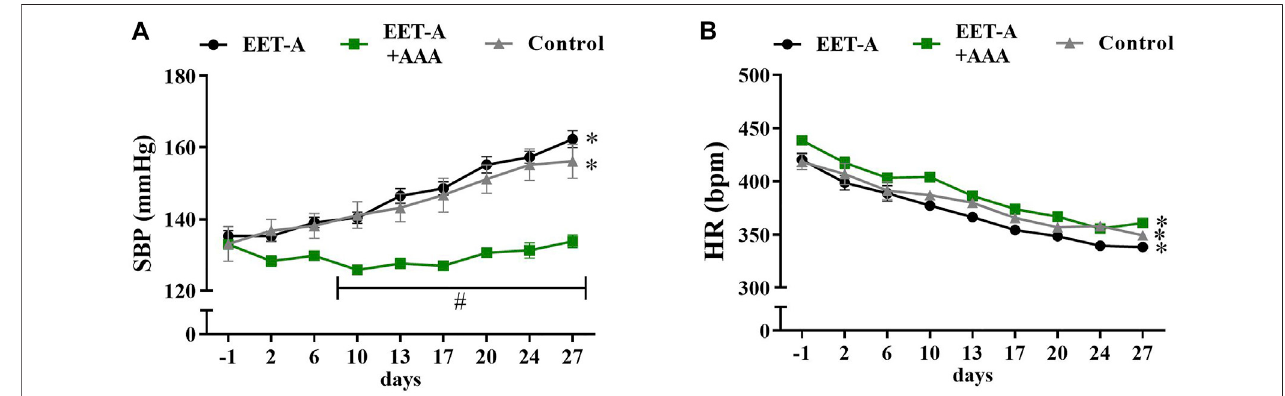
FIGURE 3 | Time course of (A) systolic blood pressure and (B) heart rates in young spontaneously hypertensive rats receiving epoxyeicosatrienoic acid analog alone (EET-A, n (cid:1) 7) or combined with 20-HETE receptor antagonist (EET-A + AAA, n (cid:1) 6), both at a dose of 10 mg/kg/day; the control group received water ( n (cid:1) 7). Values are expressed as means ± SEM. * p < 0.05 vs . baseline values (day 1) within each group by two-way analysis of variance, followed by Bonferroni ’ s multiple- comparisons test; # p < 0.05 EET-A + AAA vs . EET-A and the control group at the same time point by two-way analysis of variance, followed by Tukey ’ s post- hoc test.